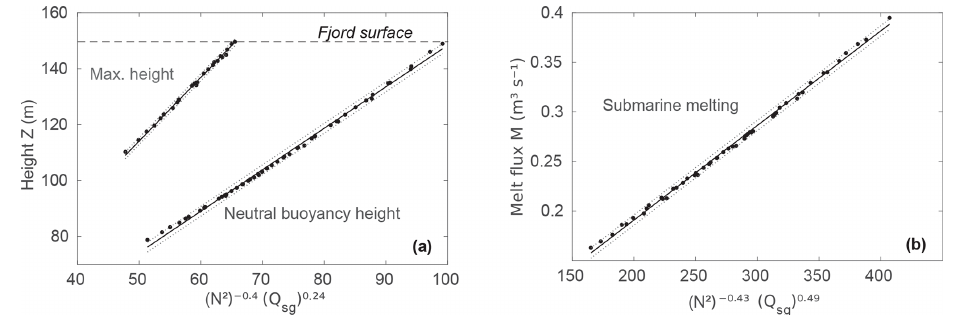
Figure 11. Scaling for (a) characteristic plume heights from the source and (b) total submarine melt rates from the source to the neutral buoyancy height. Plume model results are plotted by black dots. Straight and dotted black lines represent fitting curves according to Eqs. (2) and (4) and 95% confidence bounds, respectively. The fjord surface level has been included in panel (a) as a dashed horizontal